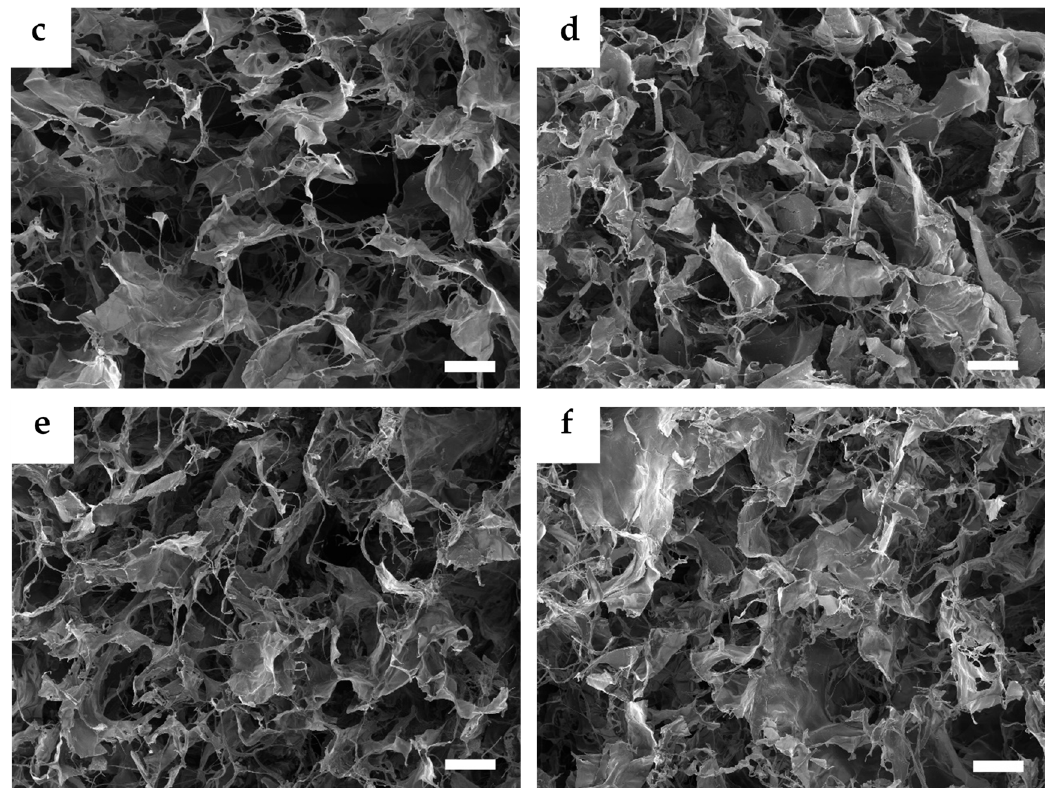
Figure 1. Cross-sectional SEM images of the following samples: C ( a ), CCH ( b ), C/SeCH ( c ), CCH/SeCH ( d ), C/SeCE ( e ), CCH/SeCE ( f ). Images of sectioned porous scaffolds were acquired at 250–274× magnification with a scale of 200 µm, displaying an area of 1.4 × 1.0–2.0 × 1.5 mm 2 .